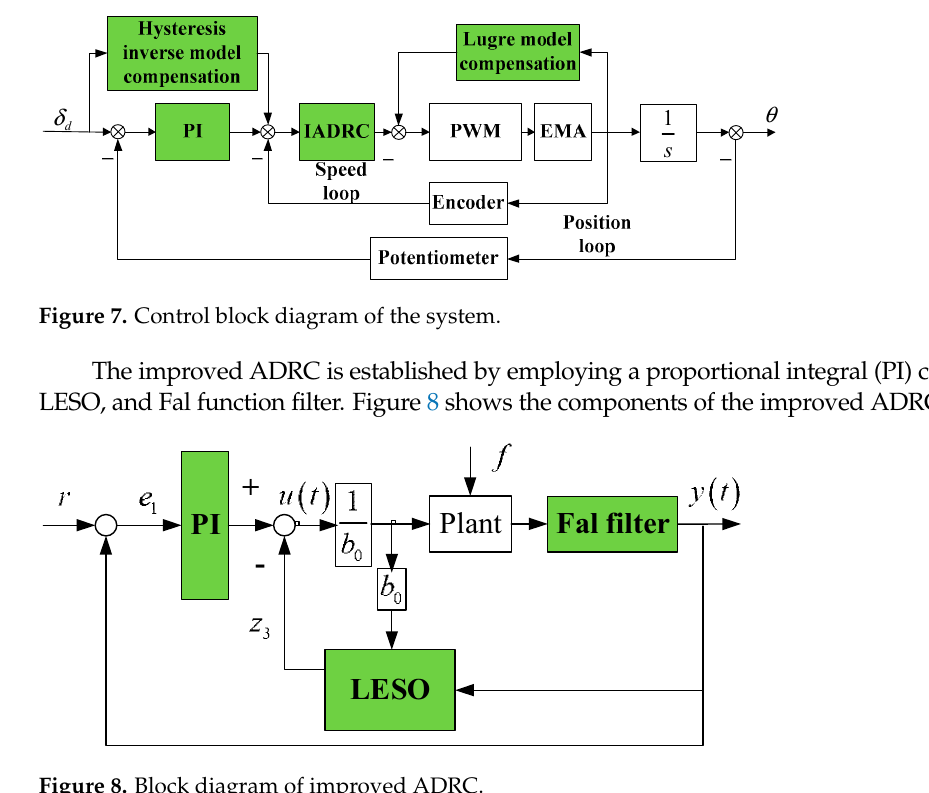
Figure 8. Block diagram of improved ADRC.